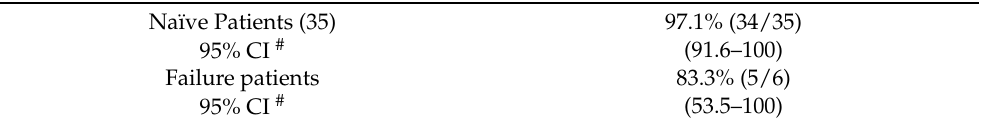
Table 4. Prevalence of cure rates per protocol according to failure or naïve patients for H. pylori